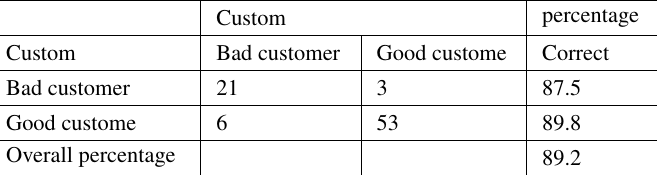
Table 8 The prediction of the model when the cut-off point is